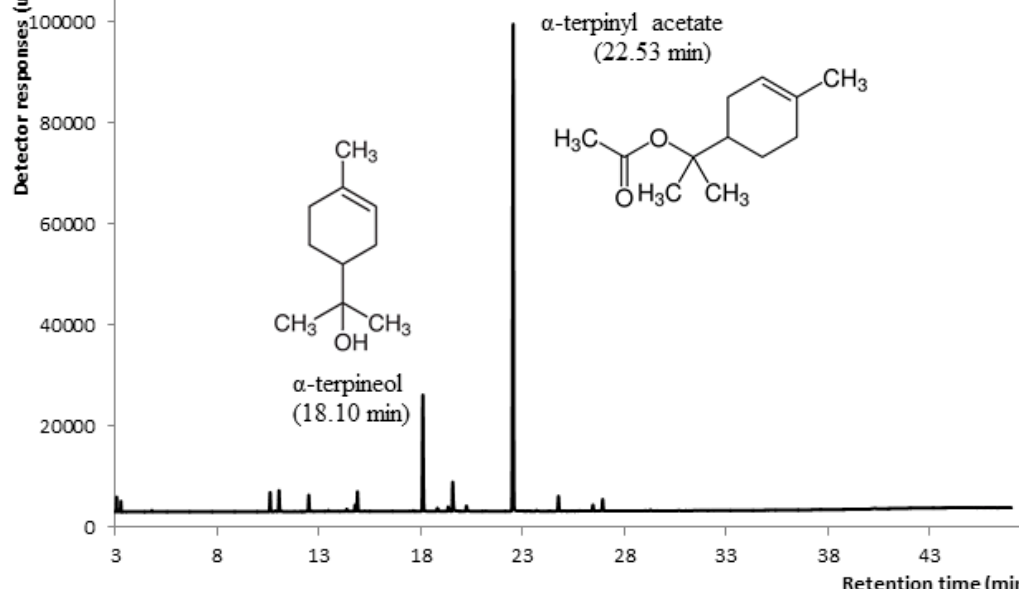
Figure 3. Capillary GC analysis of Thymus pulegioides α -terpinyl acetate essential oil.